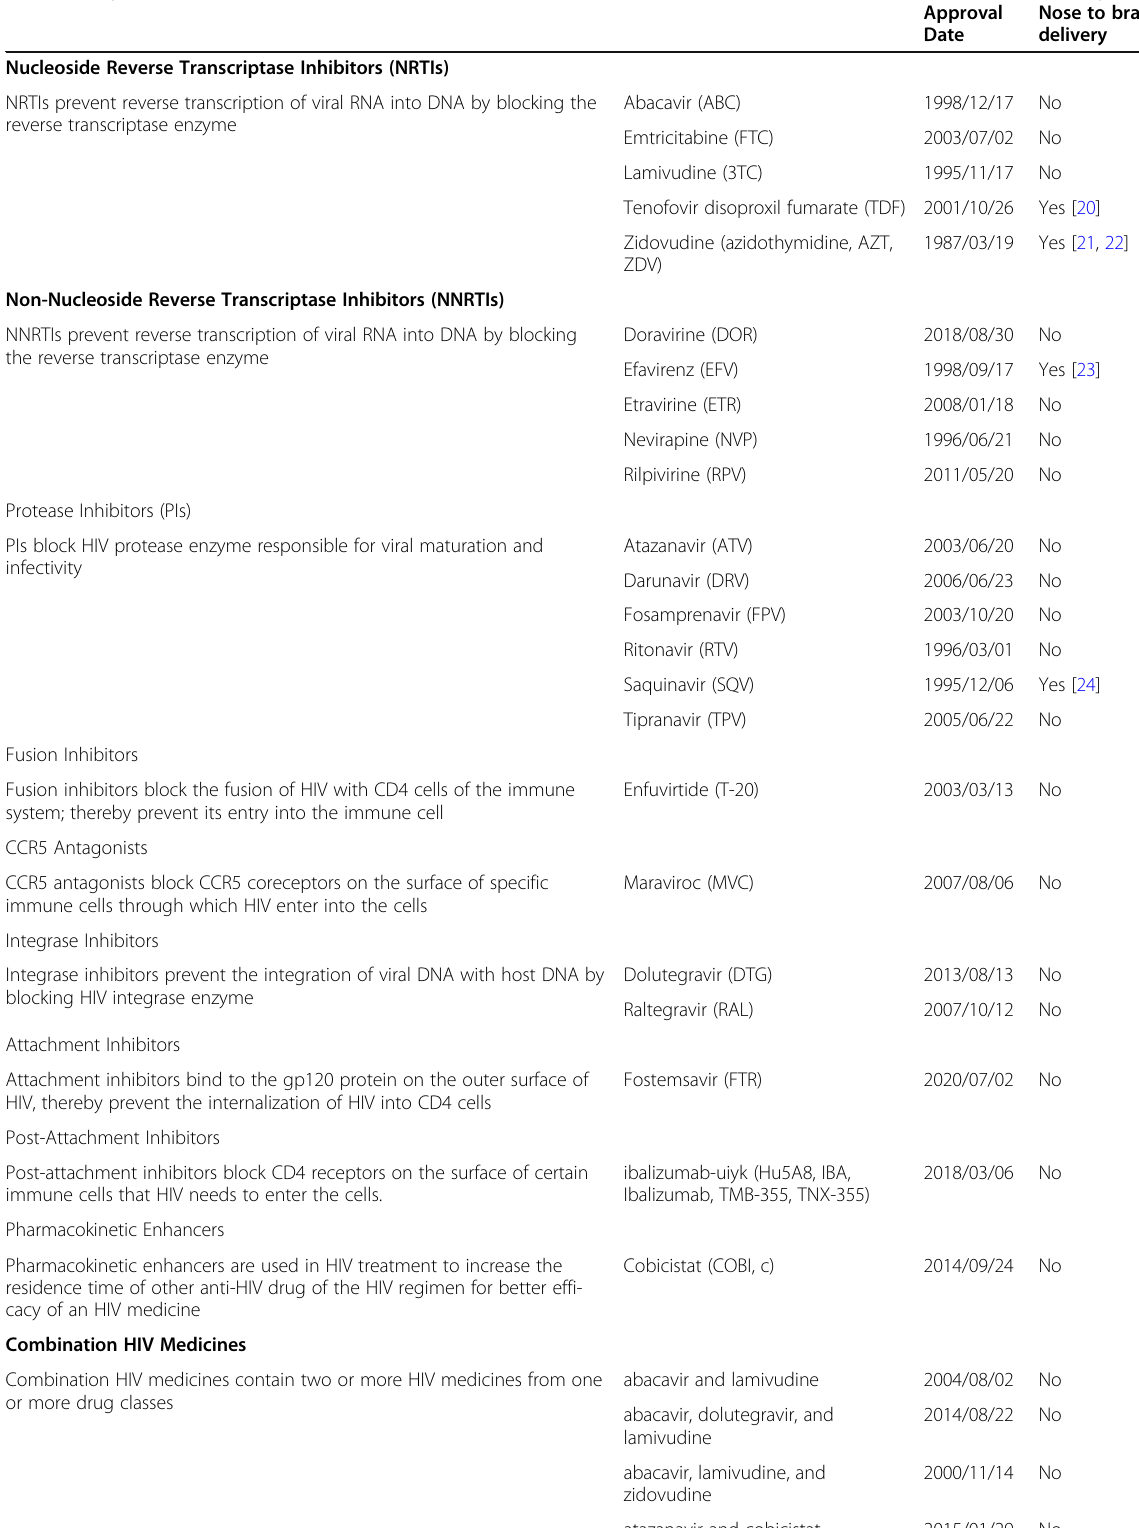
Table 1 US FDA approved antiretroviral drugs and status of their nose to brain